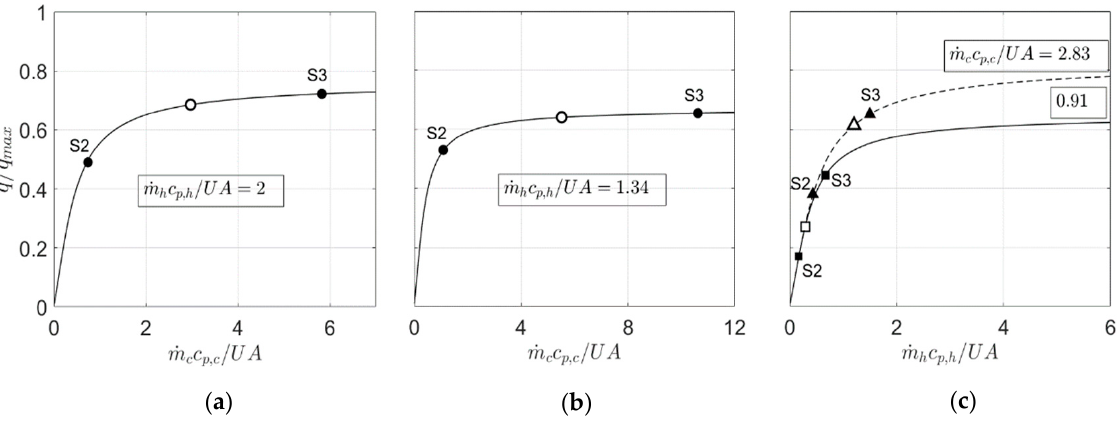
Figure 6. Operation regions for the heat exchangers in ( a ) Design B, ( b ) Design C, ( c ) Designs D1 (solid line) and D2 (broken line). The open symbols refer to the nominal operating conditions; the closed ones to the new steady-state conditions reached in control Scenario 2 (S2) and control Scenario 3 (S3). Note that both curves in ( c ) retain a physical meaning only up to a value of 𝑚(cid:4662) (cid:3035) equal to the total flowrate of hot fluid.